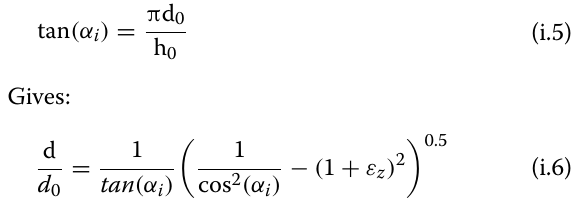
Figure 18 is the experimental raults for the rubber that was use under the range of strin between 0 to 30%, as can be seen the beahvior of the rubber linear at the range which align with the assuming for the model.